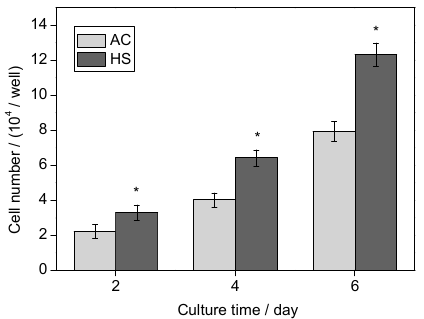
Figure 7. Cell proliferative activity of osteoblasts on different specimens. * Significantly different compared with AC.